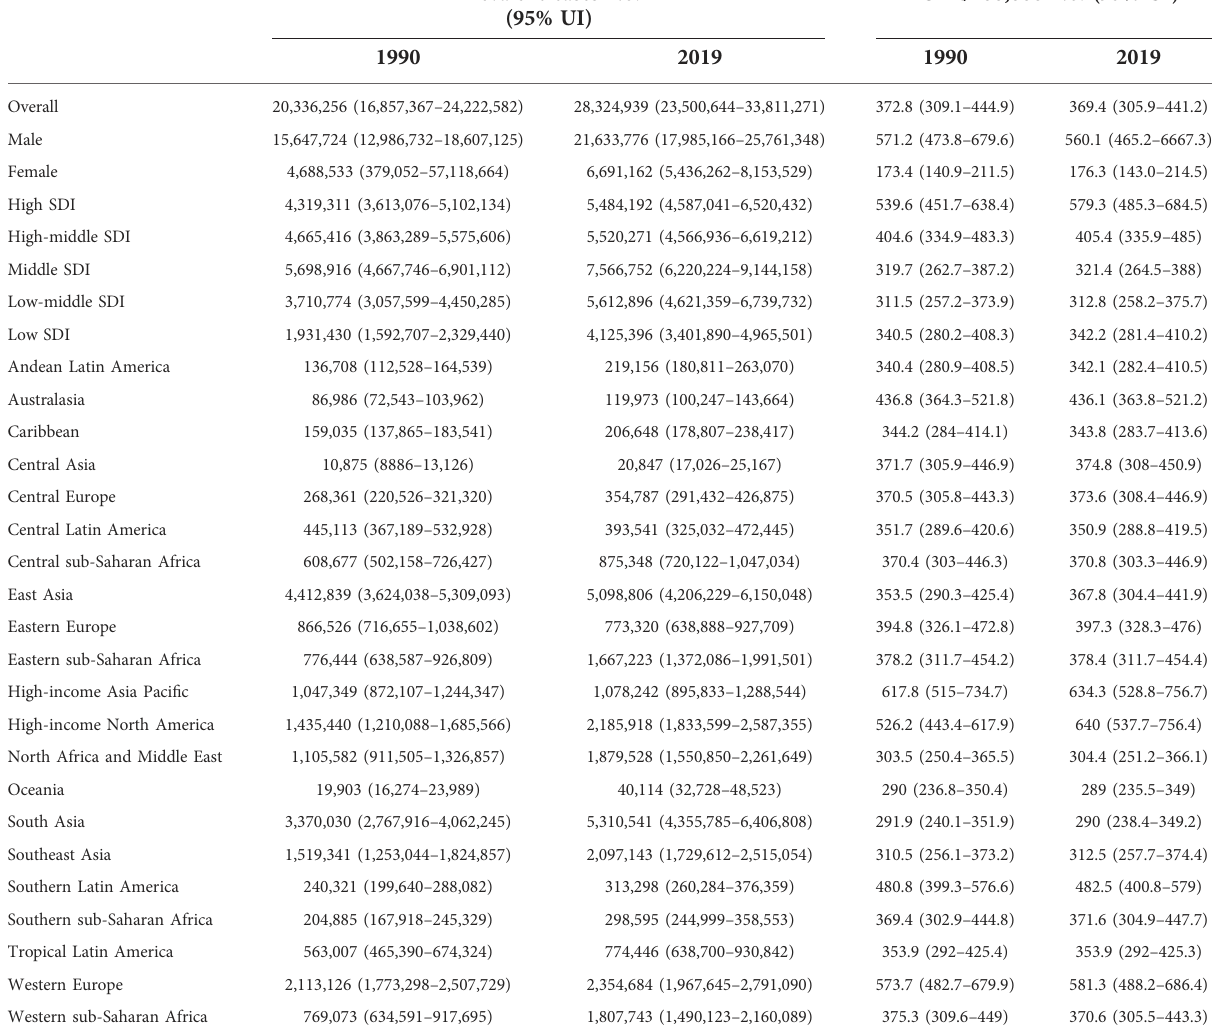
Prevalent cases No. (95%